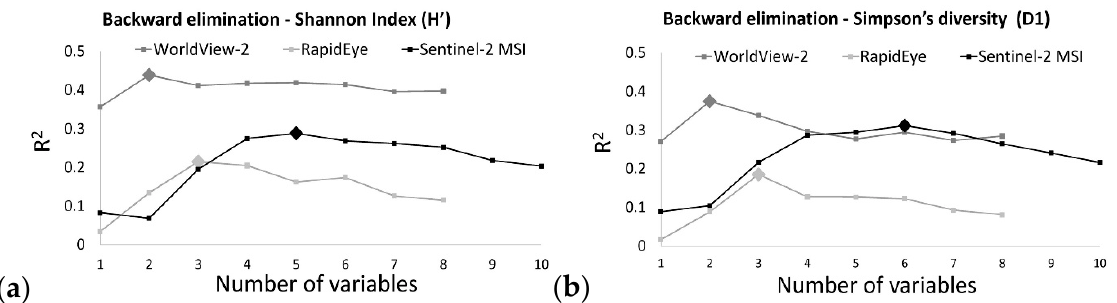
Figure 6. The optimal number of variables based on the backward elimination process for estimating ( a ) Shannon index ( H ’) and ( b ) Simpson’s diversity ( D1 ), using Random Forest models. The most accurate model for H’ is derived from the WorldView-2 data (Table 3) considering two variables ( R 2 = 0.44, RMSE =0.29). The sentinel-2 MSI model included five variables ( R 2 = 0.29, RMSE =0.35), slightly higher than the models of Landsat-8 ( R 2 = 0.27, RMSE =0.34) and RapidEye models ( R 2 = 0.21, RMSE =0.35).